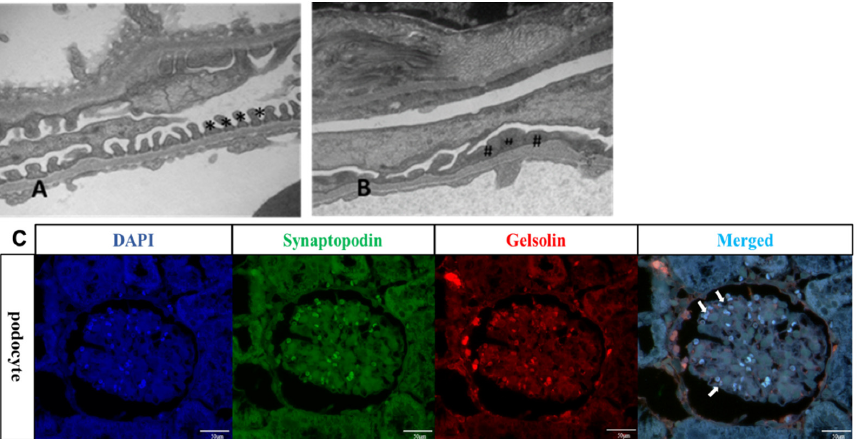
Figure 5. TEM images of mouse glomerular filtration barrier and IF images of mouse podocytes. ( A ) Podocytes of control mice (Saline injection) appear intact (*) under TEM. (Magnification: 30,000×). ( B ) Podocytes of PAN mice showed effacement (#) under TEM. (Magnification: 30,000×). ( C ) Representative micrographs showing immunostained of synaptopodin (green) and gelsolin (red) on glomerular. Podocytes were shown in a white arrow. (Magnification: 400×). (PAN = Puromycin aminonucleoside).